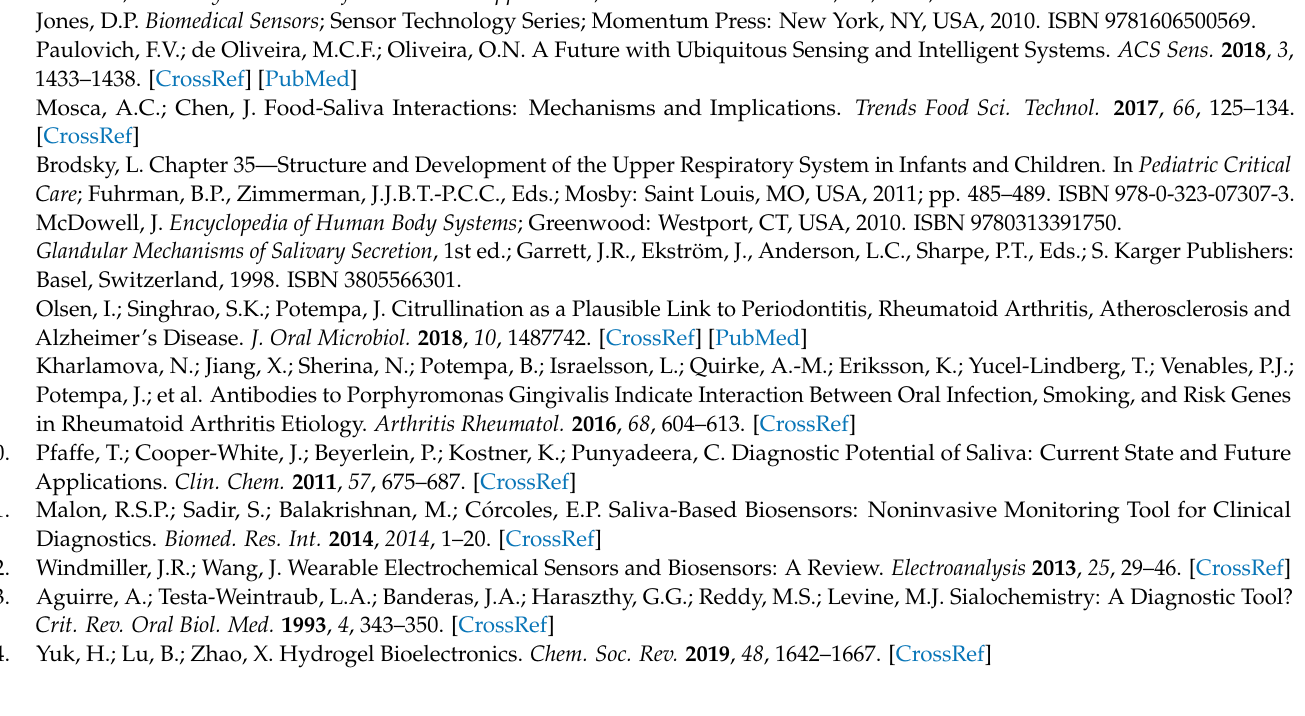
Table S2: Summary of Neurology Study Characteristics; Table S3: Summary of Physical Medicine and Rehabilitation Study Characteristics; Table S4: Summary of Internal Medicine Study Characteristics; Table S5: Summary of Obstetrics Study Characteristics; Table S6: Summary of Aerospace Medicine Study